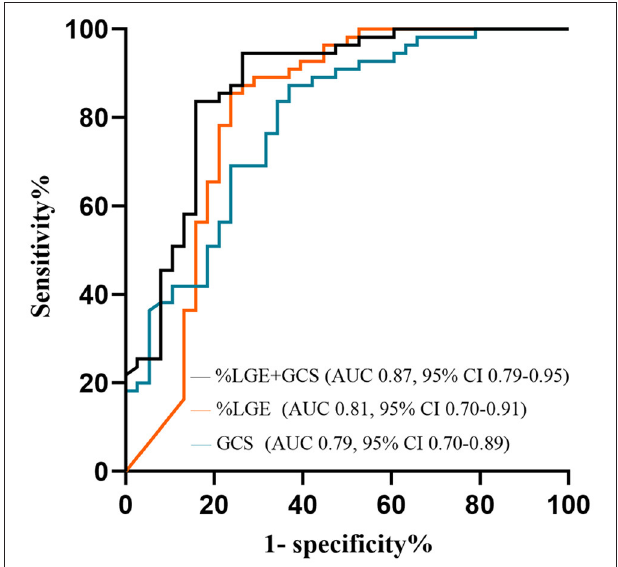
FIGURE 5 | ROC curves to assess the ability of %LGE and GCS in identifying HCM patients with VAs. AUC, area under the curve; GCS, global circumferential strain; HCM, hypertrophic cardiomyopathy; LGE, late gadolinium enhancement; ROC, receiver operator characteristic; VA, ventricular